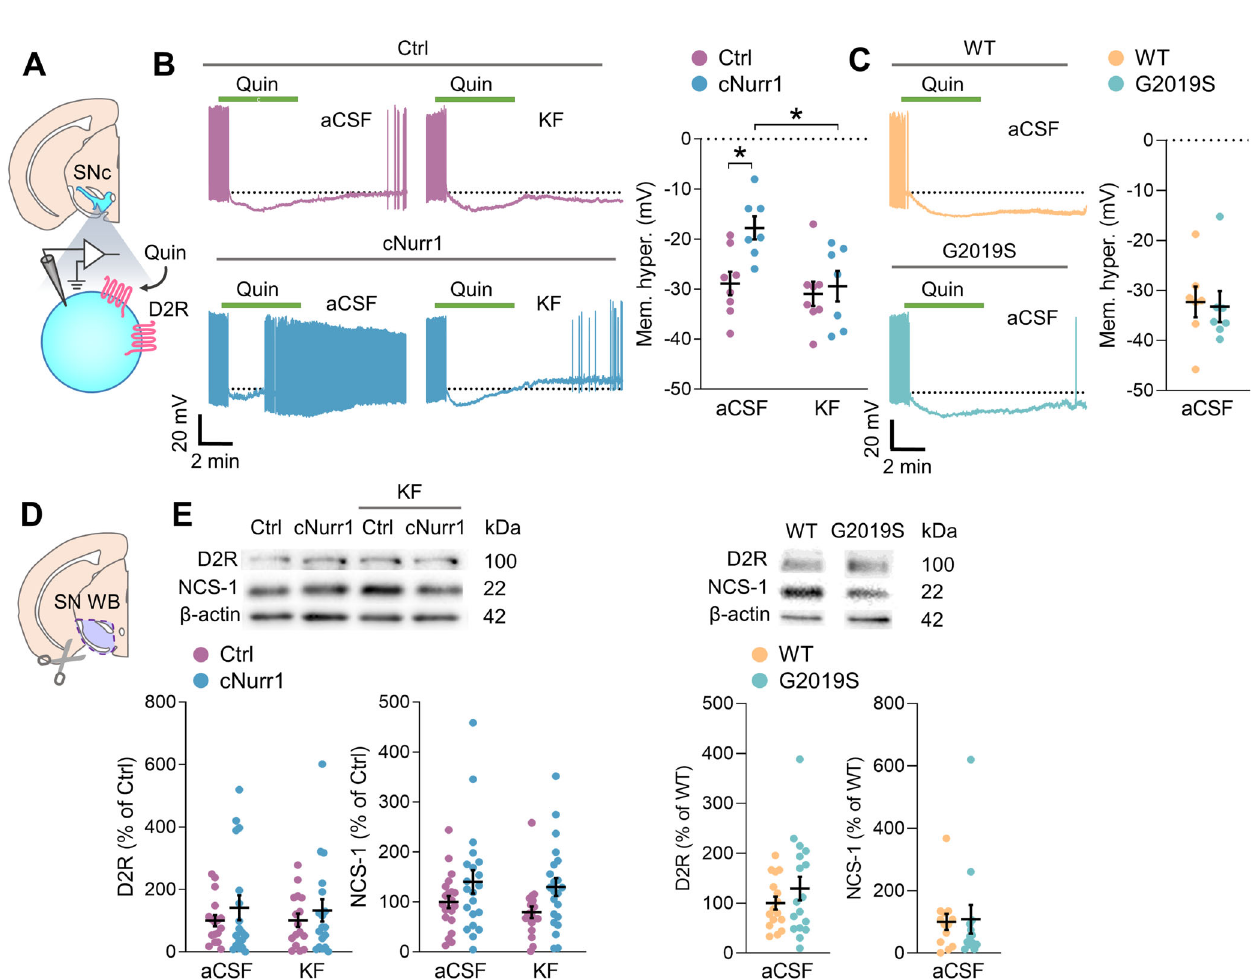
Fig. 6 Decreased DA-D2 autoreceptor function in SNc-DA neurons of cNurr1 mice. A Schematic representation depicting the SNc and a DA neuron. The DA-D2 receptor (D2R) agonist Quinpirole (Quin) was used in this experiment. B , C Representative current-clamp recordings of the pacemaker fi ring measured at resting membrane potential (dotted lines) before, during and after the perfusion with quinpirole (10 μ M, 60 sec) in control slices (aCSF) and in slices incubated with kaempferol (KF, 5 μ M). Graphs show the amplitude of the quinpirole-induced membrane hyperpolarization. n = 8 and 7 neurons in aCSF from N = 4 Ctrl and 3 cNurr1 mice; n = 8 and 7 neurons in kaempferol from N = 3 Ctrl and 6 cNurr1 mice ( B ). * P < 0.05; Two-way ANOVA followed by Multiple comparisons (Tukey). n = 7 and 7 neurons in aCSF from N = 6 WT and 5 G2019S mice ( C ). D , E Western blotting of D2R and NCS-1 in the ventral midbrain region containing the SNc of N = 17 Ctrl, 18 cNurr1, 16 WT and 17 G2019S mice from control conditions (aCSF) and N = 16 Ctrl and 18 cNurr1 mice from slices incubated in kaempferol